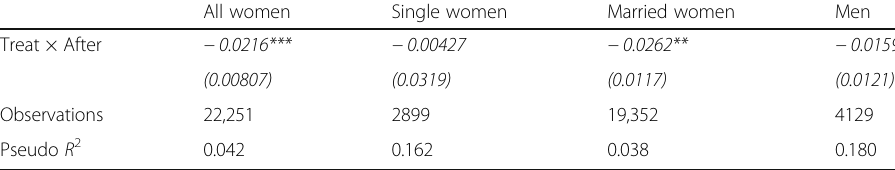
Table 3 Effect of AUH on the probability of entering the labor force. Difference-in-differences Probit